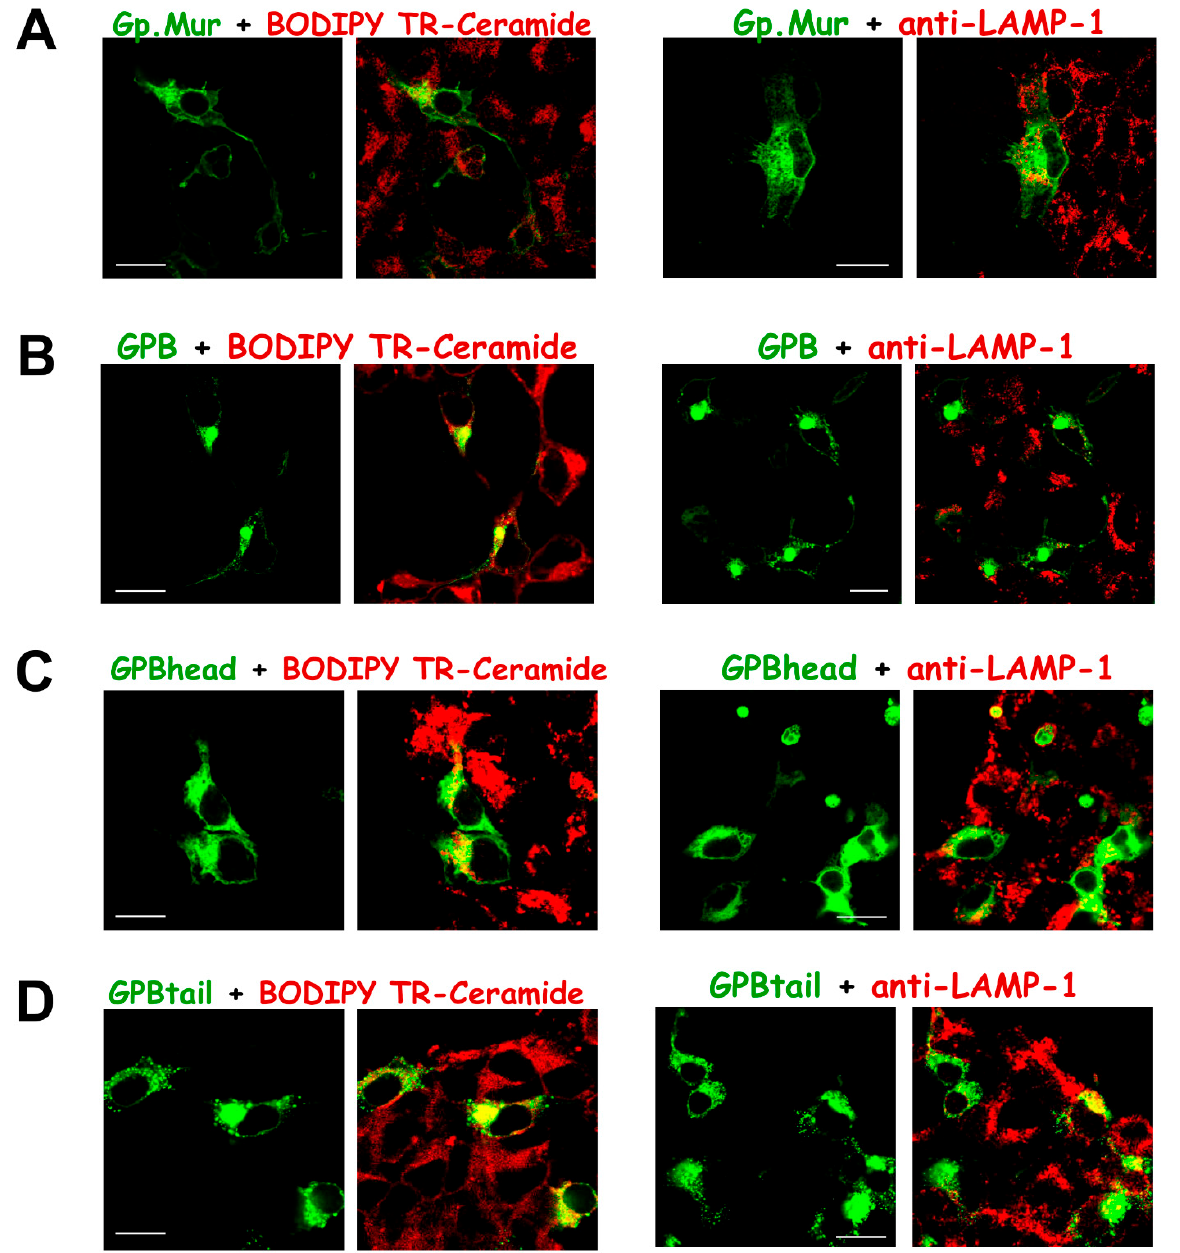
Figure 5. GPB and GPBtail, but not GP.Mur or GPBhead, expressed predominantly in the Golgi apparatus, suggesting a Golgi retention signal embedded in the glycophorin TM domain. HEK-293 cells were transfected with only ( A ) GPMURgfp, ( B ) GPBgfp, ( C ) GPBhead-GFP, or ( D ) GPBtail-GFP. On the second day post-transfection, the cells were labeled with a lipid marker for the Golgi apparatus—BODIPY TR-ceramide (left panel), or with mouse anti-LAMP-1 (a protein marker for lysosomes) following AF568 conjugated anti-mouse antibody (right panel). Scale bar = 25 μ m.